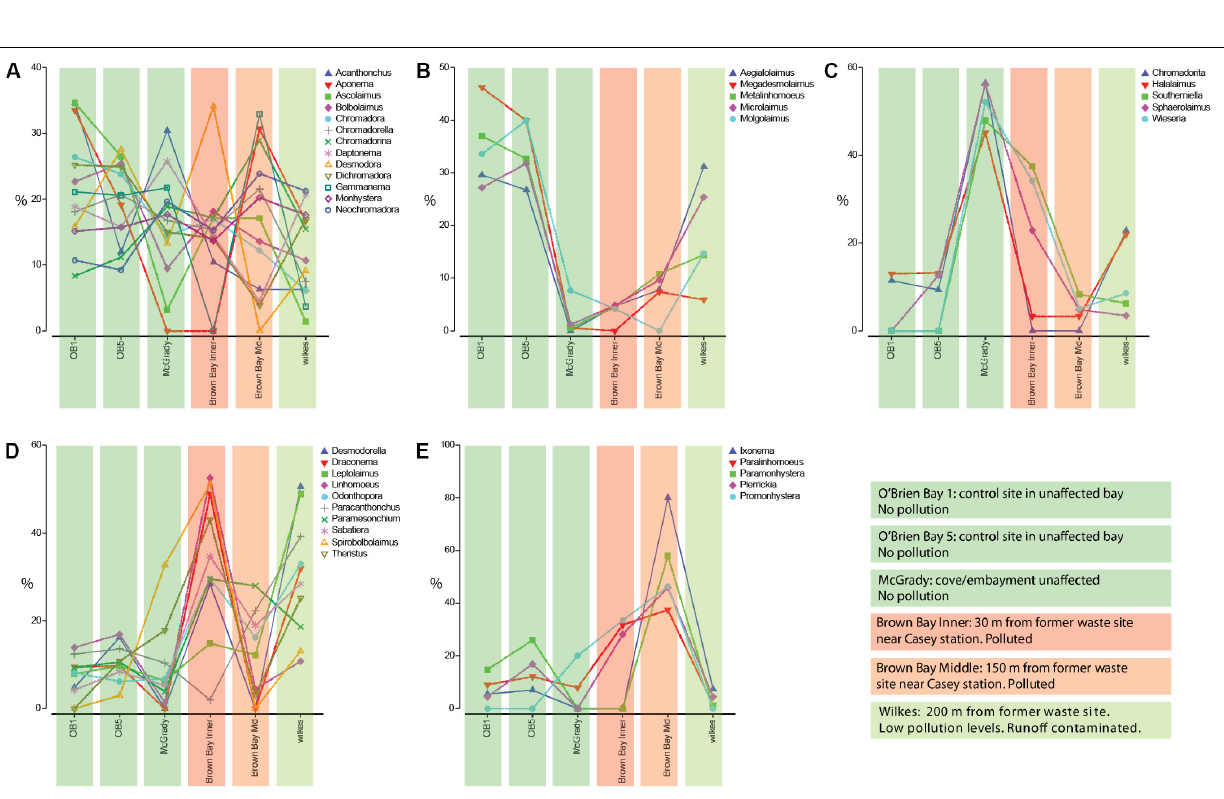
Frontiers in Marine Science |